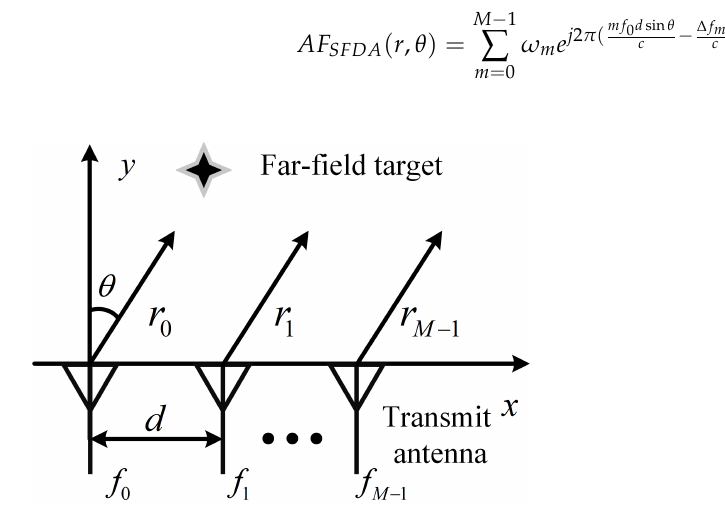
Figure 1. The schematic diagram of standard frequency diverse